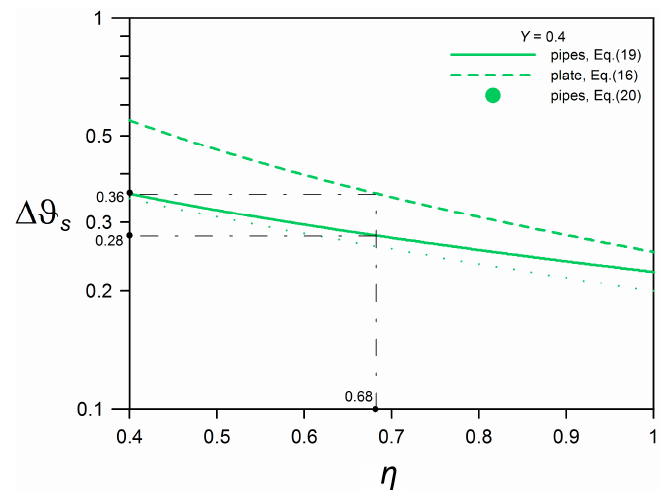
Figure 9. Comparison of dependencies (16) and (19) for long process duration.